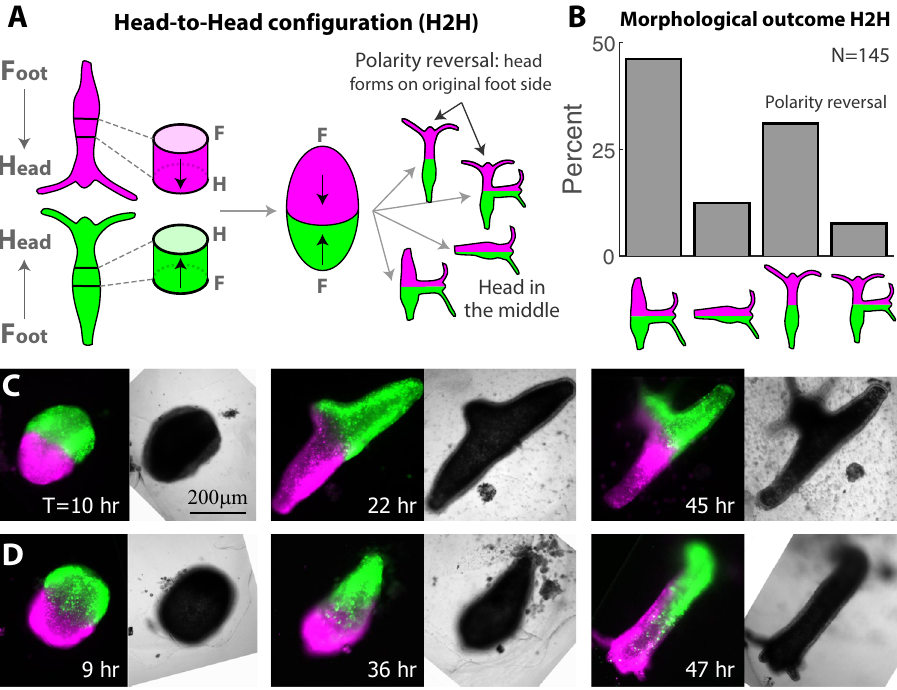
Figure 1. Polarity rearrangement in regenerating Head-to-Head (H2H) ring doublets. ( A ) Schematic illustration of the regeneration experiments with fused ring doublets in the H2H configuration. Two rings are excised from different animals (labeled in green or magenta). The rings adhere to each other at their head-facing sides, and the regeneration of the fused ring doublet is followed over time. ( B ) Bar plot depicting the outcome morphologies of fused H2H ring doublets. Experiments were performed on 164 samples. 2/164 disintegrated, 17/164 did not regenerate, and 145/164 regenerated. The outcome morphologies of the regenerated animals were categorized as: a head in the middle with two feet, a head in the middle with one foot, a head at either edge (green or magenta), a head in the middle and at the edge (“Methods”; Fig. S2). All but 4/145 (i.e. 97%) of the regenerated animals fell into one of these categories. The percentages of regenerated animals in each category are depicted. ( C ) Images from a time lapse movie of a H2H doublet that regenerated into an animal with a head in the middle (Movie 1). ( D ) Images from a time lapse movie of a H2H doublet that underwent polarity reversal, regenerating into a normal morphology with a head developing from an originally foot-facing side of one of the excised rings (Movie 2). The panels in ( C , D ) depict combined epifluorescence (left; green—AlexaFluor 647-conjugated 10 kD dextran, magenta—Texas Red-conjugated 3kD dextran) and bright-field (right) images at the specified time points during the regeneration (time after excision in